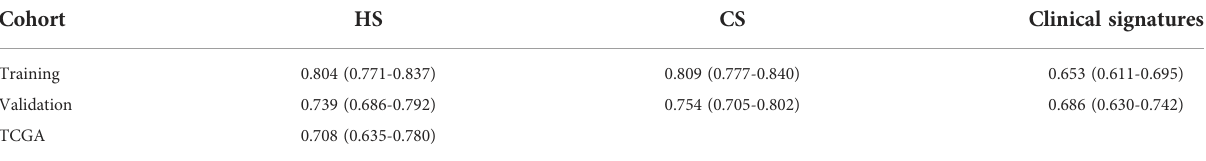
TABLE 1 C-indexes of the novel scores.